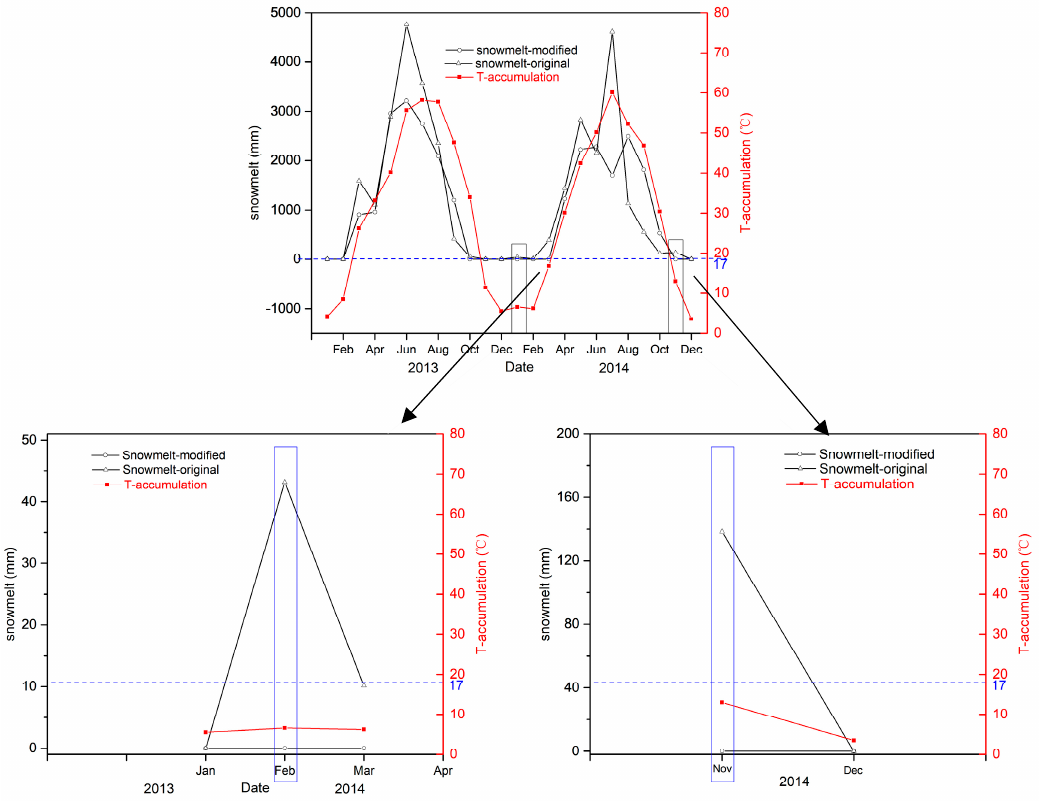
Figure 8. The relationship between monthly snow melting and accumulated temperature (AT), maximum temperature (MT) at the calibration and validation stage (2013–2014) (The red line in the figure represents the cumulative temperature threshold of snow melting.